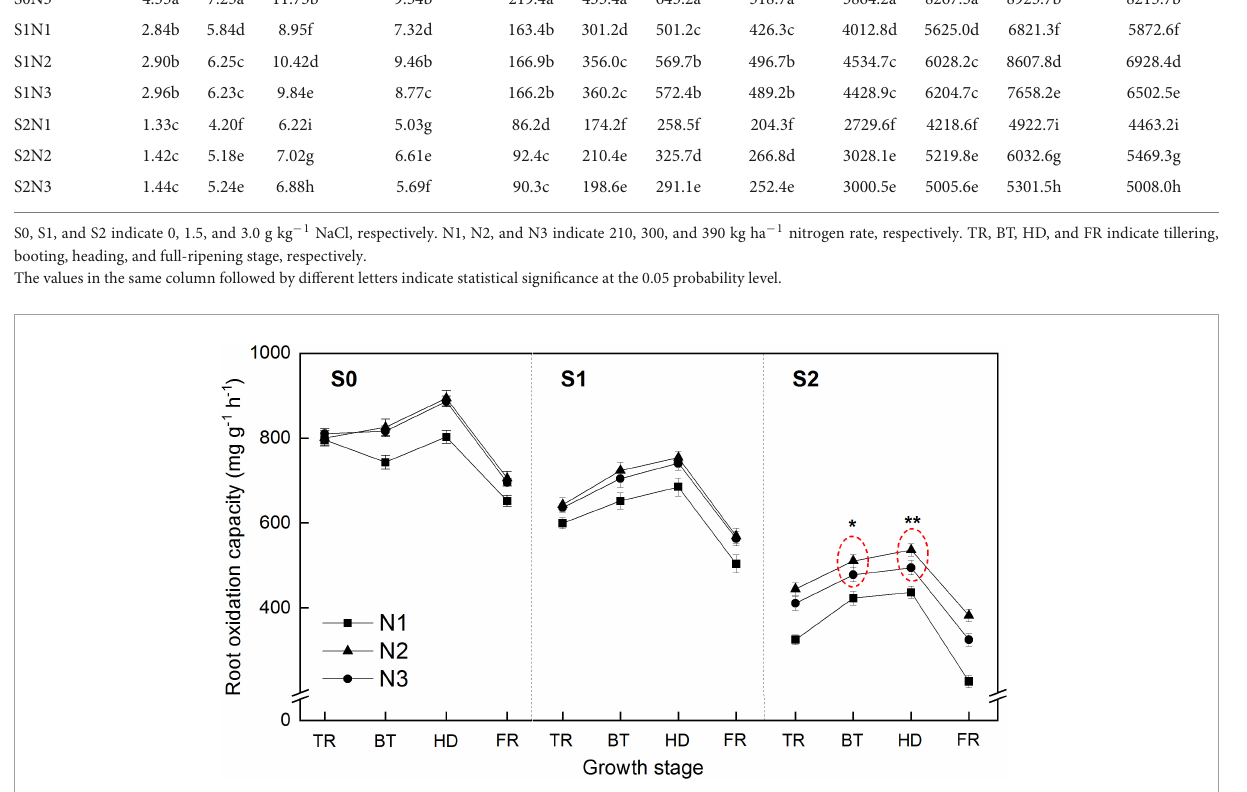
FIGURE2 Effects of different salt concentrations and nitrogen rates on rice root oxidation capacity. S 0 , S 1 and S 2 denote salt concentrations of 0, 1.5, and 3.0 g kg − 1 NaCl, respectively; N1, N2 and N3 denote nitrogen rates of 210, 300, and 390 kg ha − 1 . The data ( n = 3) are mean values ± SD, calculated from three independent experiments. *, **: Significant at the P < 0.05 and 0.01 levels,